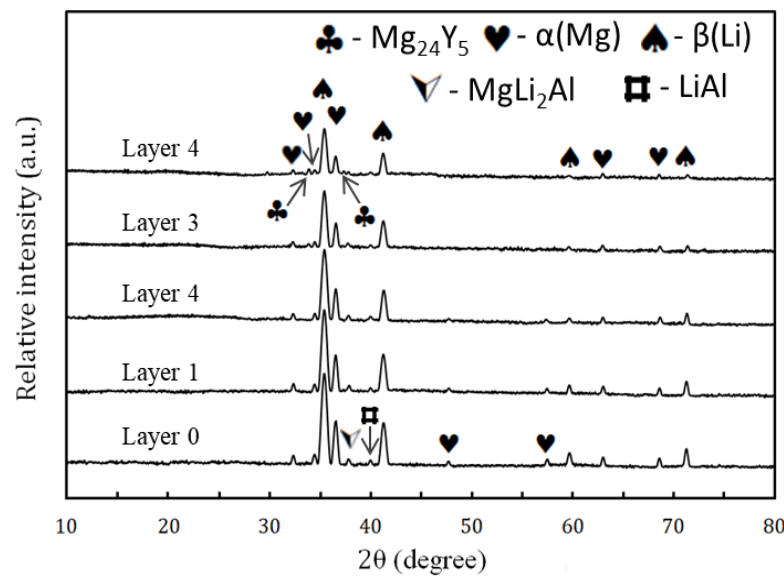
Figure 6. XRD patterns of different milled layers of FGCs.